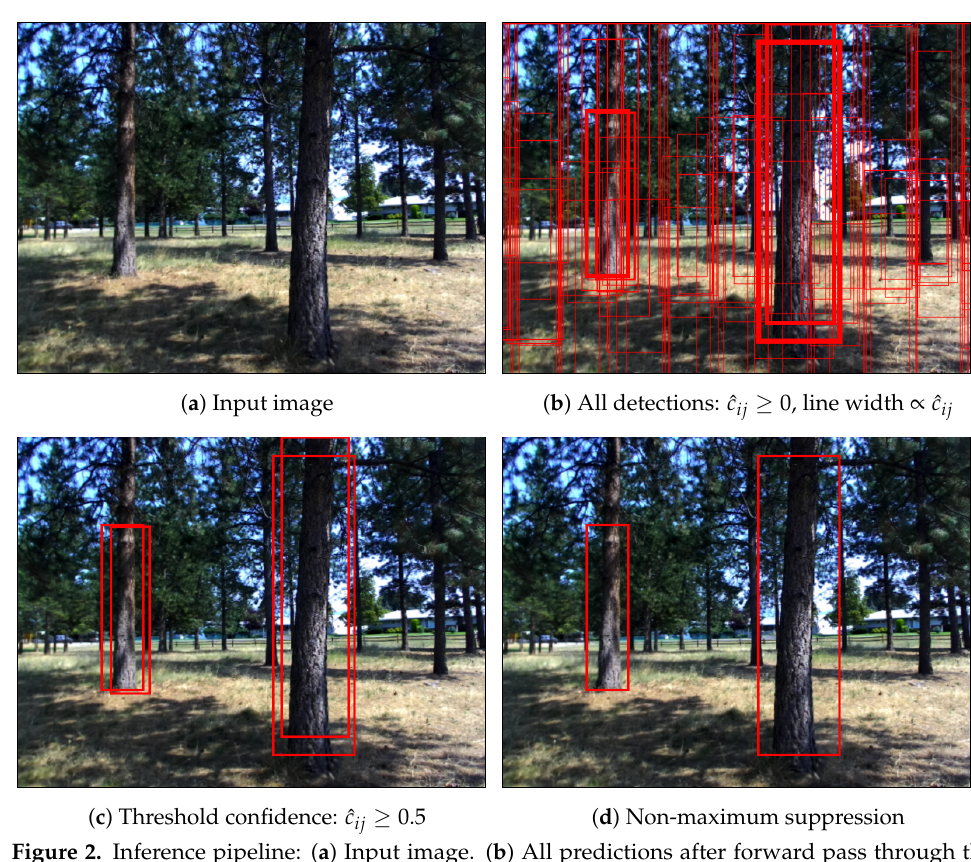
Figure 2. Inference pipeline: ( a ) Input image. ( b ) All predictions after forward pass through the network. Line widths are proportional to confidence. ( c ) Retained predictions after thresholding on the confidence. ( d ) Final prediction following non-maximum